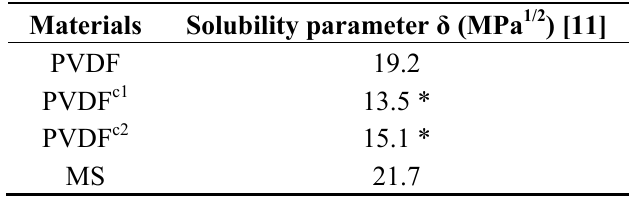
Table 2. Solubility parameters. MS, methyl salicylate.